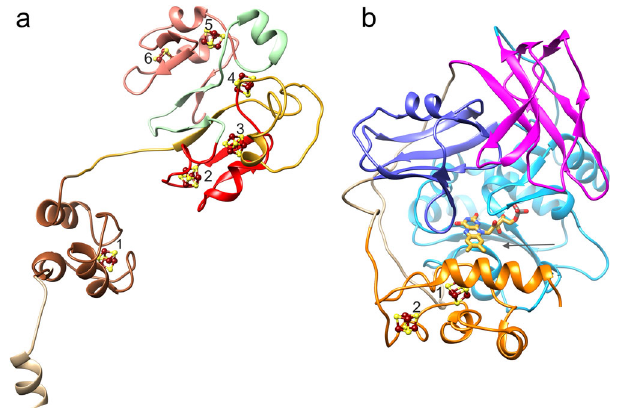
Fig. 6 | Structure of the cytoplasmic input and output subunits. a RnfB. This subunit is built up of the Fd segments FdI (brown), FdII (red), and FdIII (salmon). Eachof thelatterformingthe globularFeII+IIIdomaincarriestwo[4Fe-4S]clusters (Fe and S as brown and yellow spheres). One extra [4Fe-4S] cluster (4) is packed between the segment linking FdII and FdIII (light green) and the RnfC interface segment (gold). The Fd(I) segment is too mobile for reliable model building. Therefore,theFdIstructurewascalculatedbyAlphafold2.Thepositionofthe[4Fe- 4S] clusters was derived from four clustered cysteines but also from a related Fd domain of a corrinoid iron-sulfur protein 37 . b RnfC. The subunit is architecturally composed of an N-terminal α , β module built up of three subdomains and a C-terminalFddomain(orange)carrying two[4Fe-4S] clusters. Theubiquinone-like subdomain (magenta) consists of two three-stranded antiparallel β -strands (30 – 101) packing against each other and the NuoF-like subdomains (sky blue and blue)ofafour-strandedparallel β -sheetsurroundedbythreehelices(102 – 282)and a fi ve-stranded antiparallel β -sheet (283 – 352), respectively. The non-covalently bound FMN isembedded at the center of thesubunitand accessible for NAD + viaa wide cleft (see